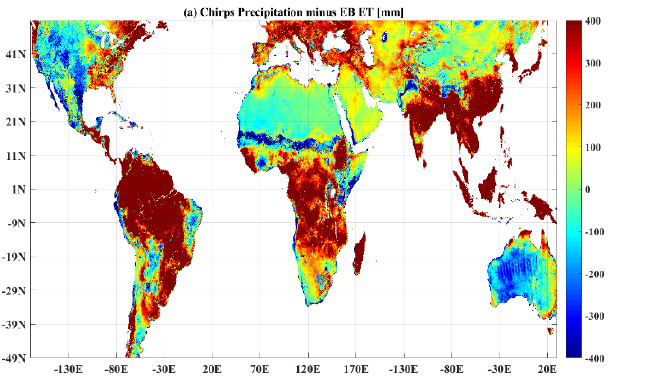
Figure 4 Annual Precipitation minus annual ET (mm) from